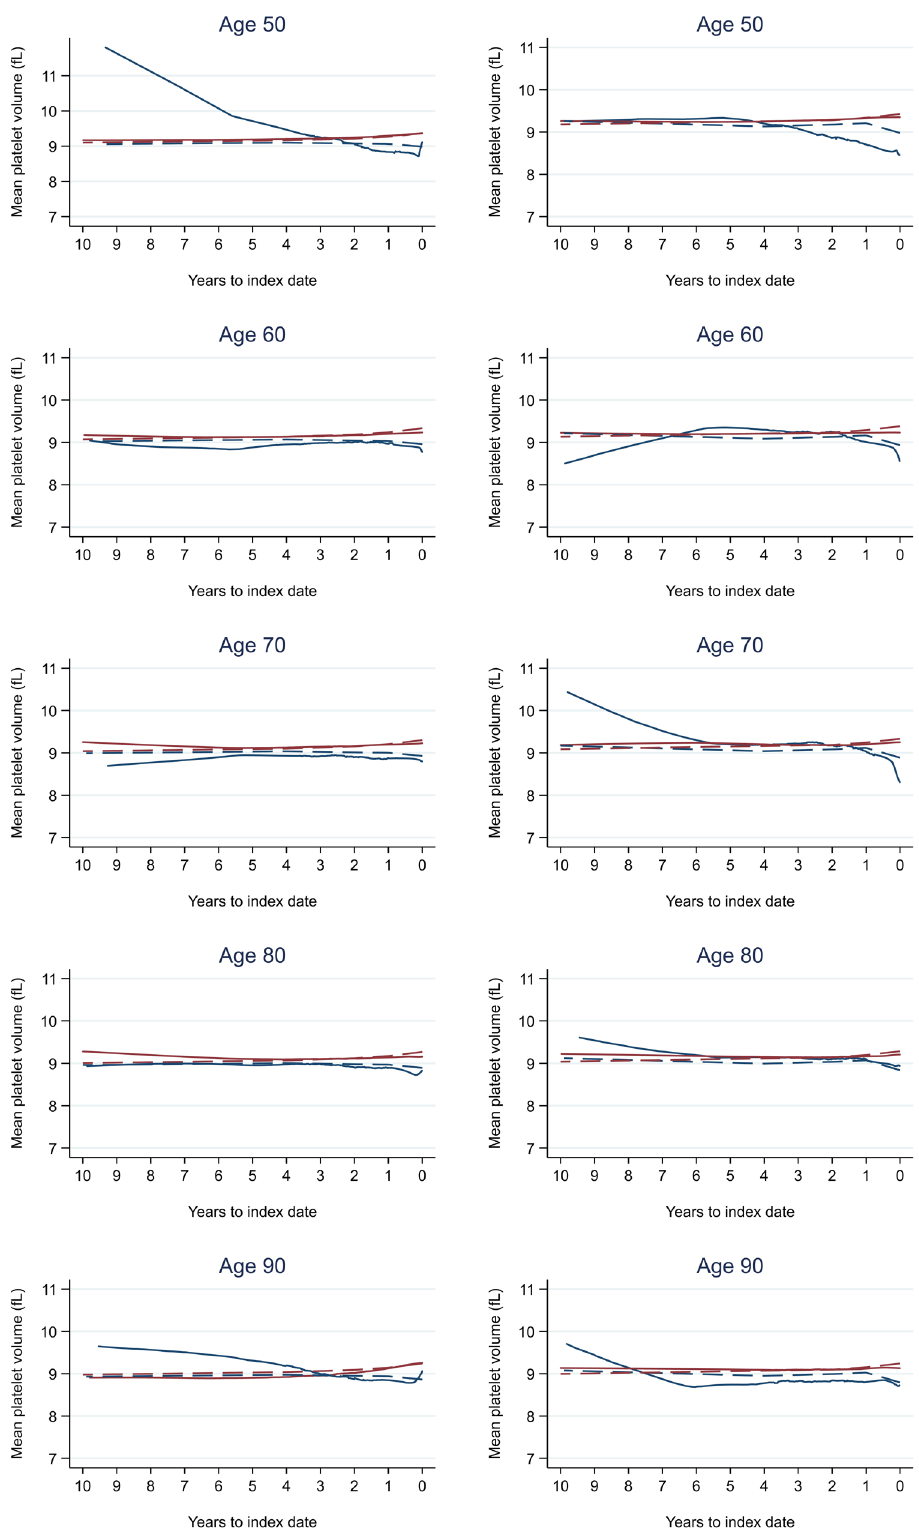
Figure 11. Mean platelet volume trends between cases and controls, by age at index date 1,2 . 1 Index date was the date of diagnosis for cases and a randomly selected date in the patient’s study period for controls. 2 LOWESS trends are age (+/- 3 years) and modelled (fixed effects) trends are taken at that specific age. Legend: males (left) and females (right). Colorectal cancer (blue line) and no cancer (red line). LOWESS trend (solid line) and modelled trend (dashed line).